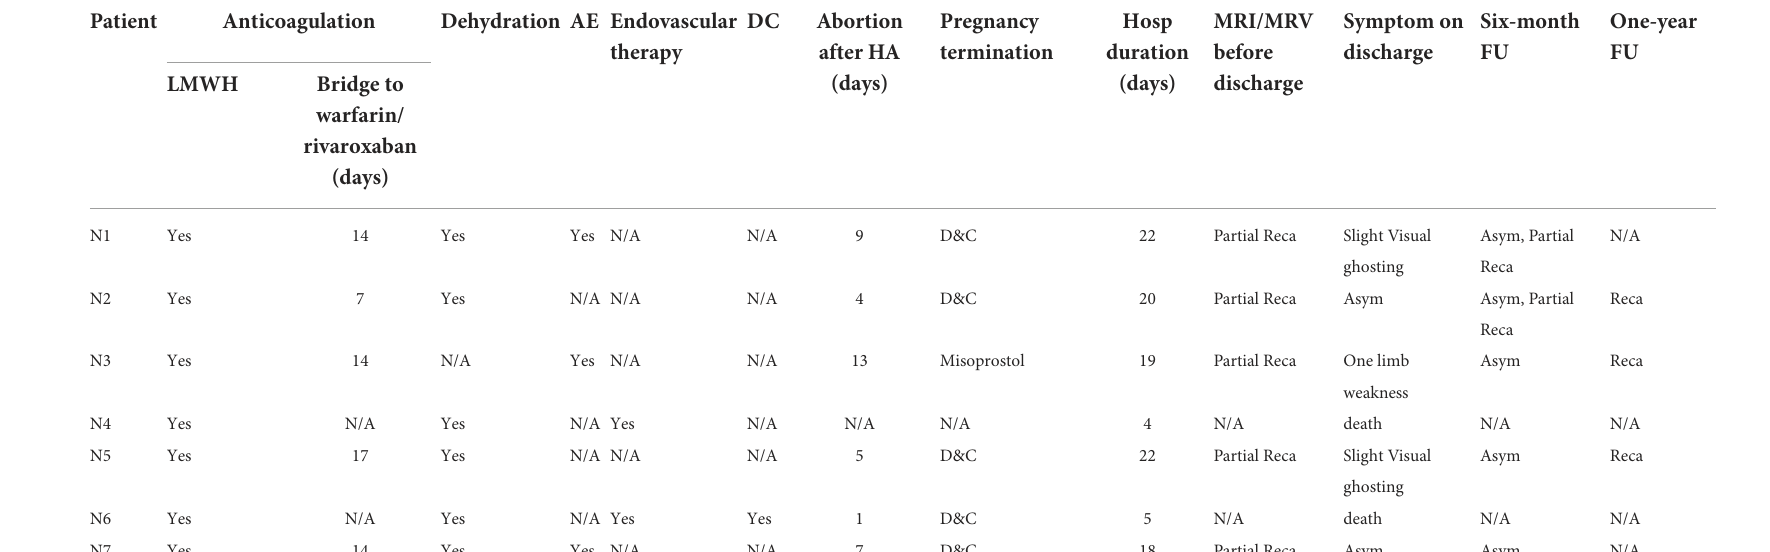
TABLE 4 Treatment and outcomes of the included patients with